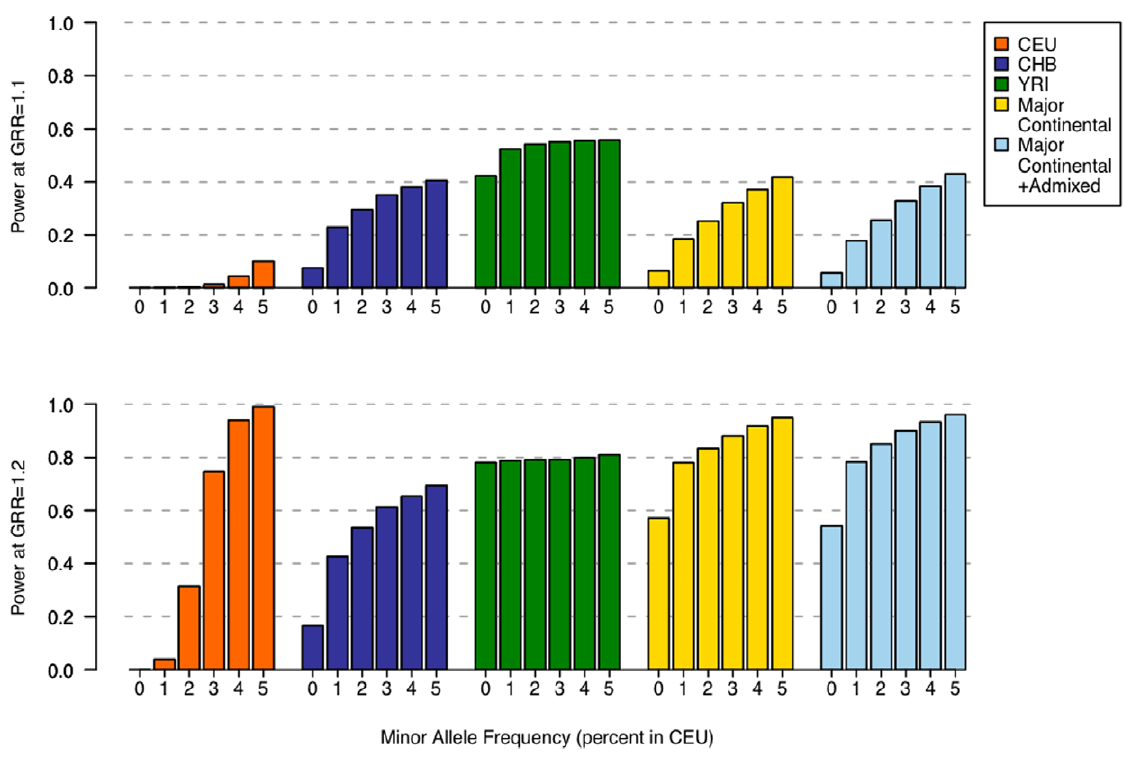
Figure 2. Power as a function of allele frequency ( # 5%) in CEU based on HapMap 3 data. For a sample size of 80,000 and a modest effect size (GRR of 1.1 and 1.2), power is given for CEU, CHB, YRI, and two multiethnic panels (‘‘major continental’’, CEU + CHB + YRI, and ‘‘cosmopolitan’’, CEU + CHB + YRI + ASW + GIH + MXL) in phase 2. Including non-European samples in phase 2 improves power to detect an association for alleles that have lower frequency in